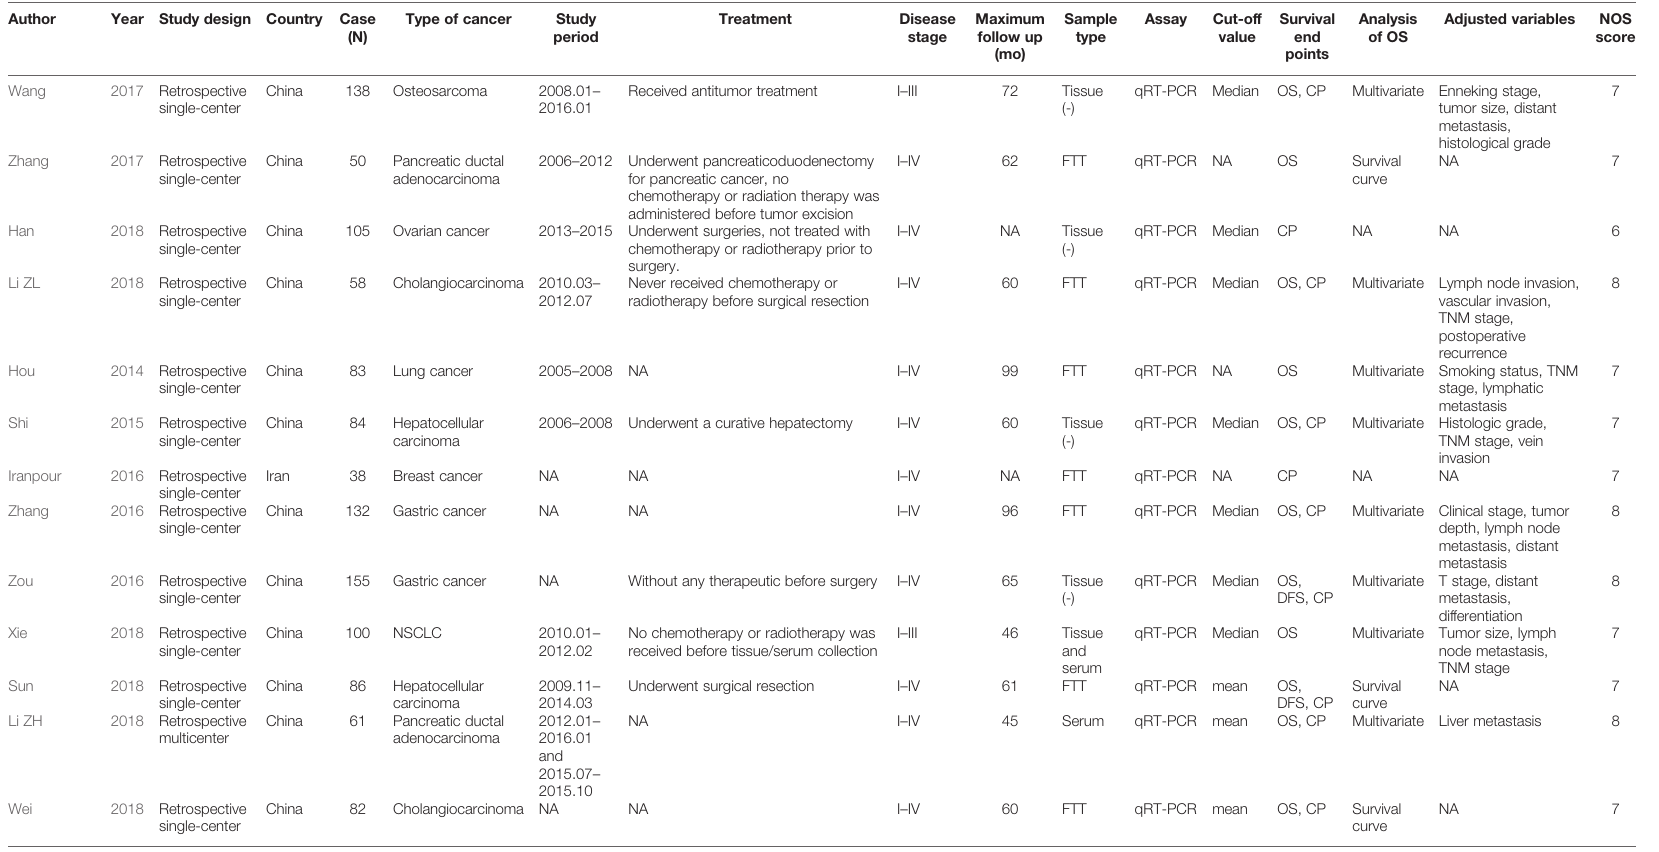
TABLE 1 | Main characteristics of the 13 included